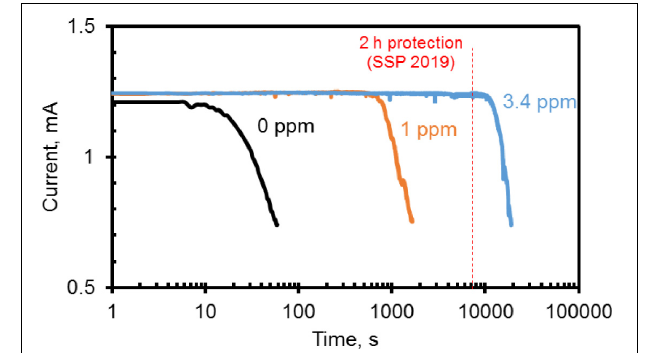
FIGURE 11 | DTPMP distribution (mg per 1 g shale rock) in Fayetteville shale rock after squeeze test.